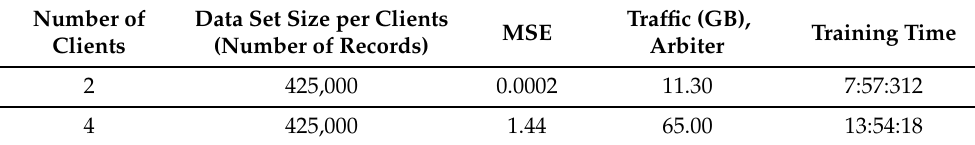
Table 5. Linear regression model: experimental settings and results obtained.